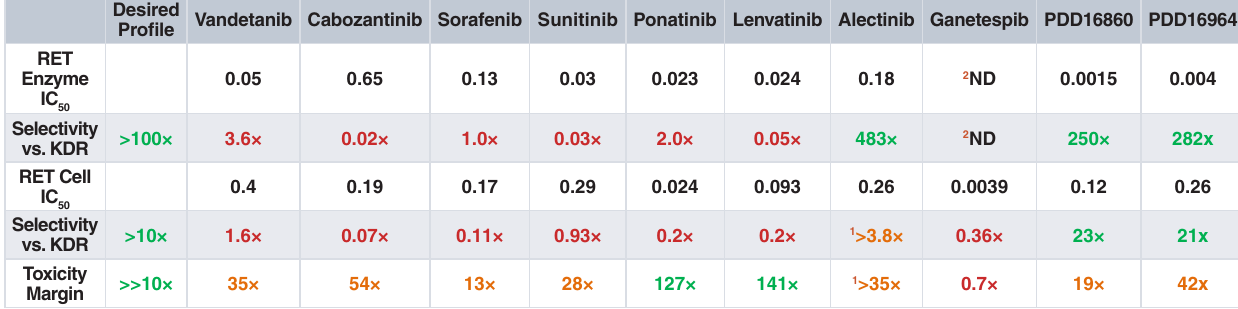
Figure 3. Correlation of cellular data: A ) POM vs POP IC vs POM IC